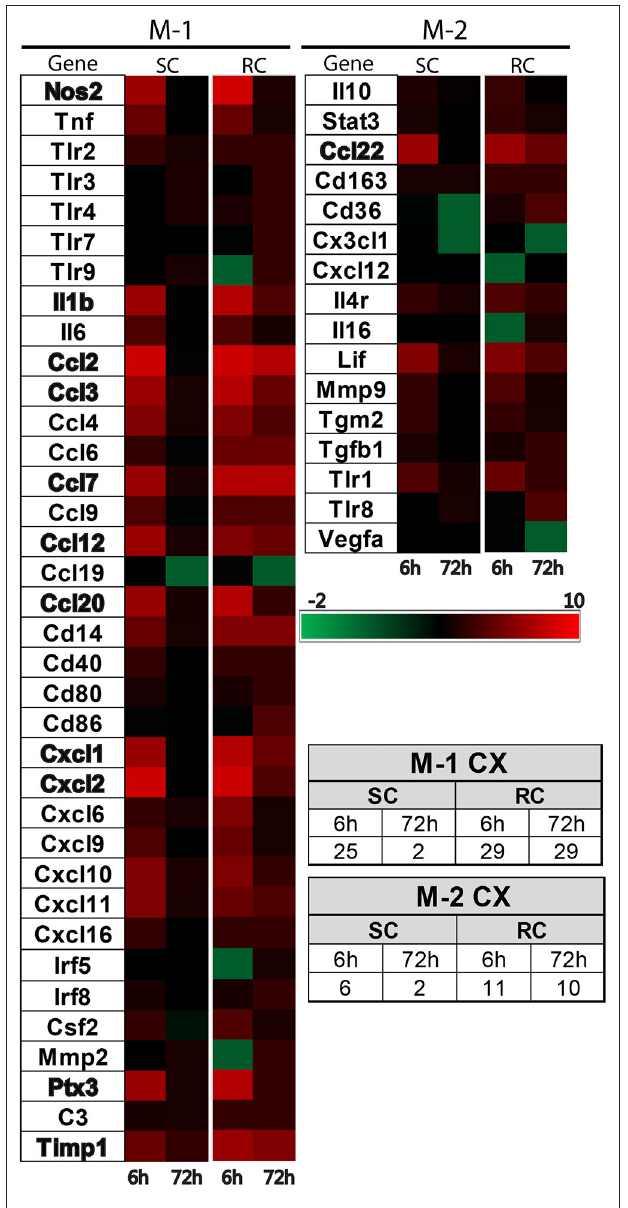
FIGURE 4 | Heat map showing inflammatory gene profile of the ipsilateral cortex following concussive brain injury. Custom designed qRT-PCR mini-array identified genes that were upregulated (Red, ≥ 1.5 fold positive changes compared to sham group) or downregulated (Green, ≥ 1 fold negative change compared to sham group). Left panel shows altered M-1 markers and right panel shows altered M-2 markers. Names of the genes that were expressed more than 6 fold are identified in bold. The table insert shows the total number of genes that were changed under each condition. SC: single concussion, RC: repeated concussion, CX: cortex.